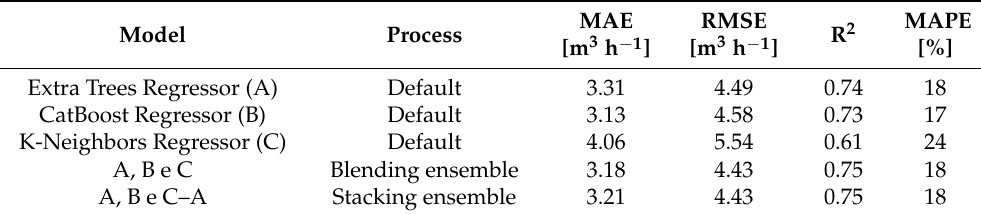
Table 8. Performance obtained on the training set, by default, stacking ensemble learning and blending ensemble learning model.